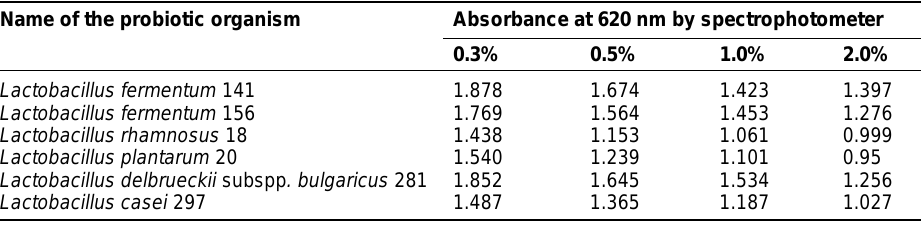
Table-2. Absorbance values of MRS broth inoculated with Lactobacillus species at different oxgall concentration (0.3 to 2.0 o %) after incubation at 37 C for 24 h. Name of the probiotic